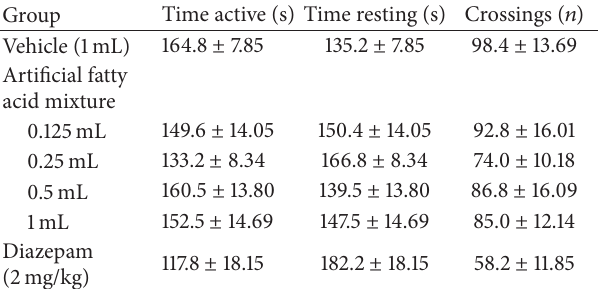
Table 2: Effect of treatment in open field test. The data are expressed as mean ± standard error of the mean. No significant differences in activity time, resting time, or crossings were found between